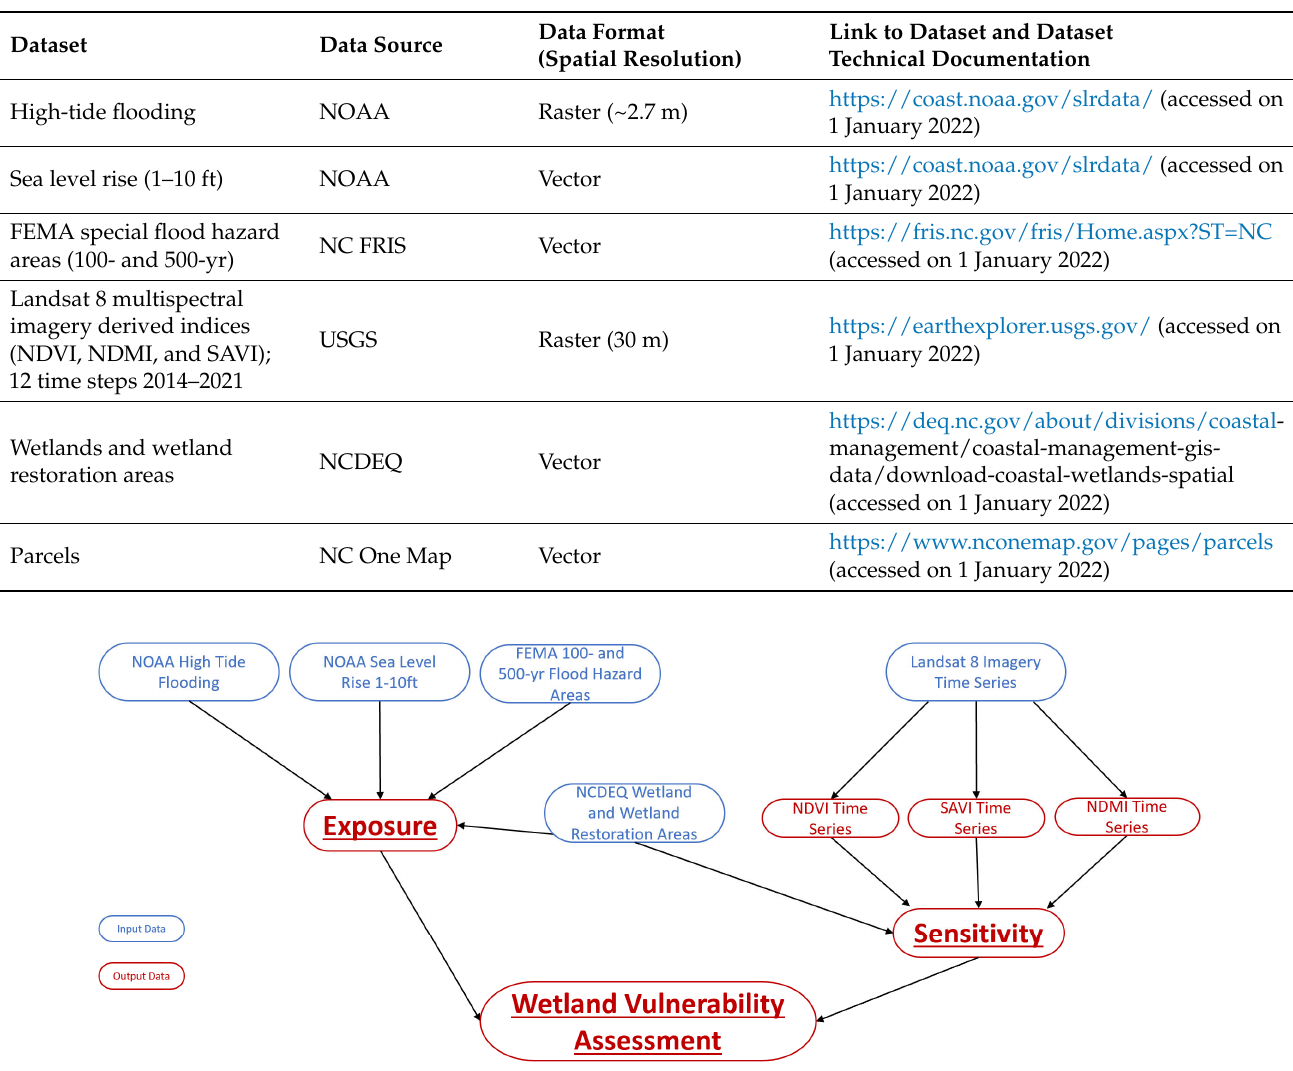
Figure 2. Summary of workflow steps to compute a wetland vulnerability assessment.